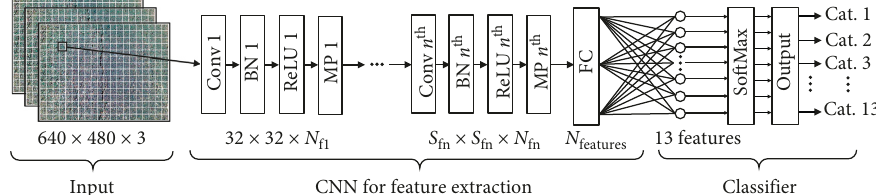
Figure 3: Network architecture used for crack detection. The number below each layer indicates the size of each layer. Conv: convolution layer, BN: batch normalization layer, MP: max-pooling layer, and FC: fully connected